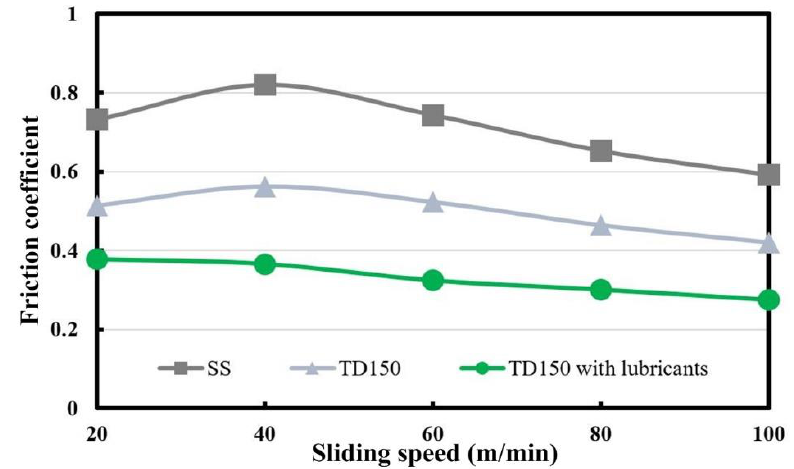
Figure 5. Average friction coefficients of different samples at different sliding speeds.